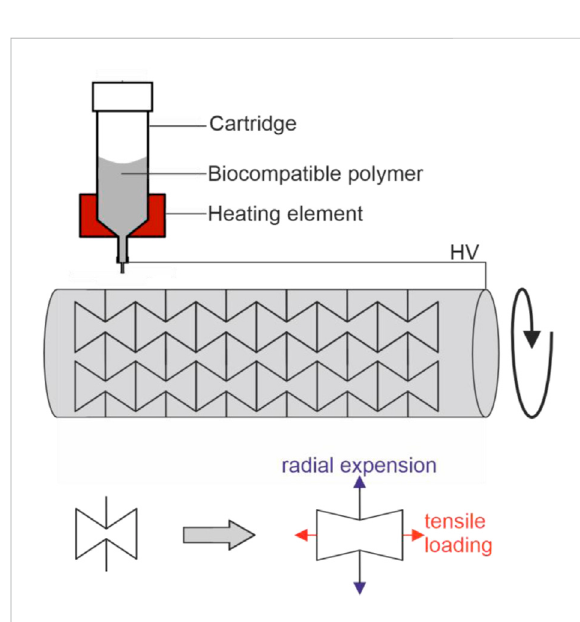
FIGURE 5 Fabrication of auxetic tubular micro fi bre scaffolds, fabricated via melt electrowriting, adopted from (Paxton et al., 2020): By using a tubular print bed, one of the axes of a conventional 3D printerisexchangedfor rotatingmandrel.Insuchasetup,the rotation speed has to be consistently adjusted with increasing numbers of layers to maintain stable printing conditions. Printing of auxetic structures lead to scaffold structure that increases in diameter (indicated in blue) when stretched (indicated in